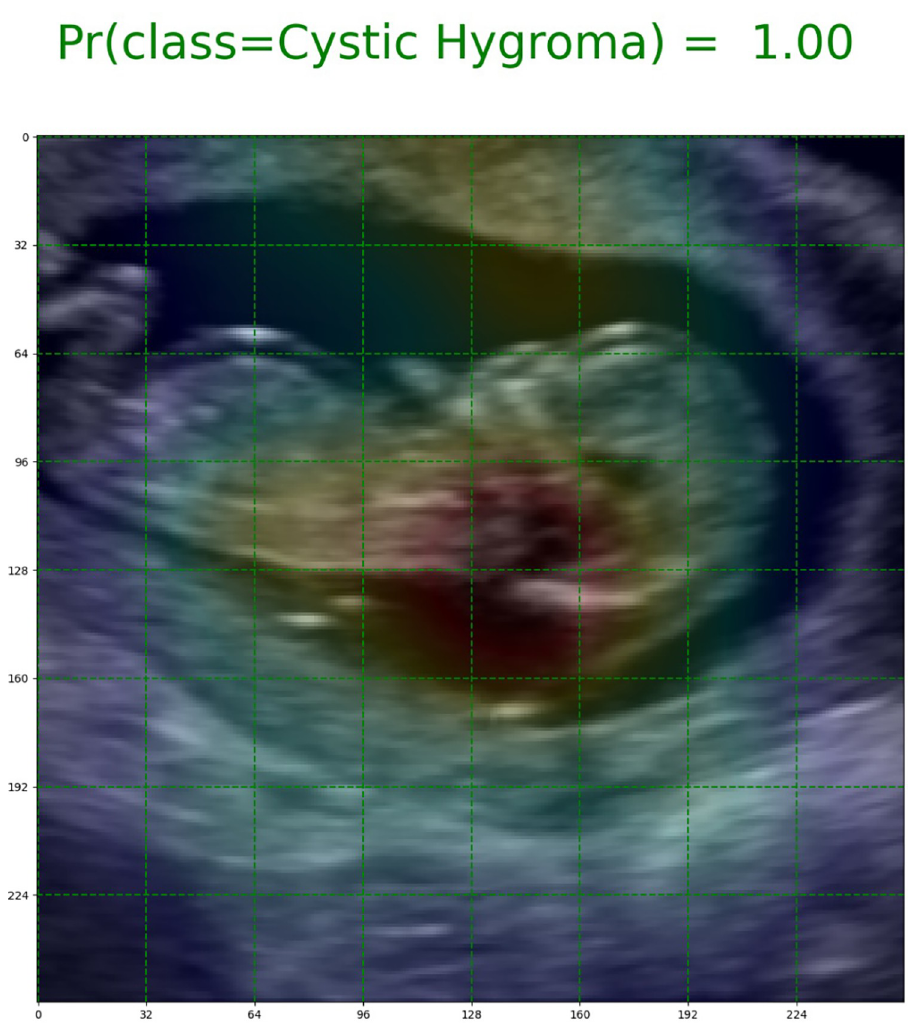
Fig 4. Grad-CAM image of a cystic hygroma case. The green gridlines indicate the size of the feature maps (8x8) used to generate the heat maps. The red highlights the region of the image that influenced the model’s prediction the most.